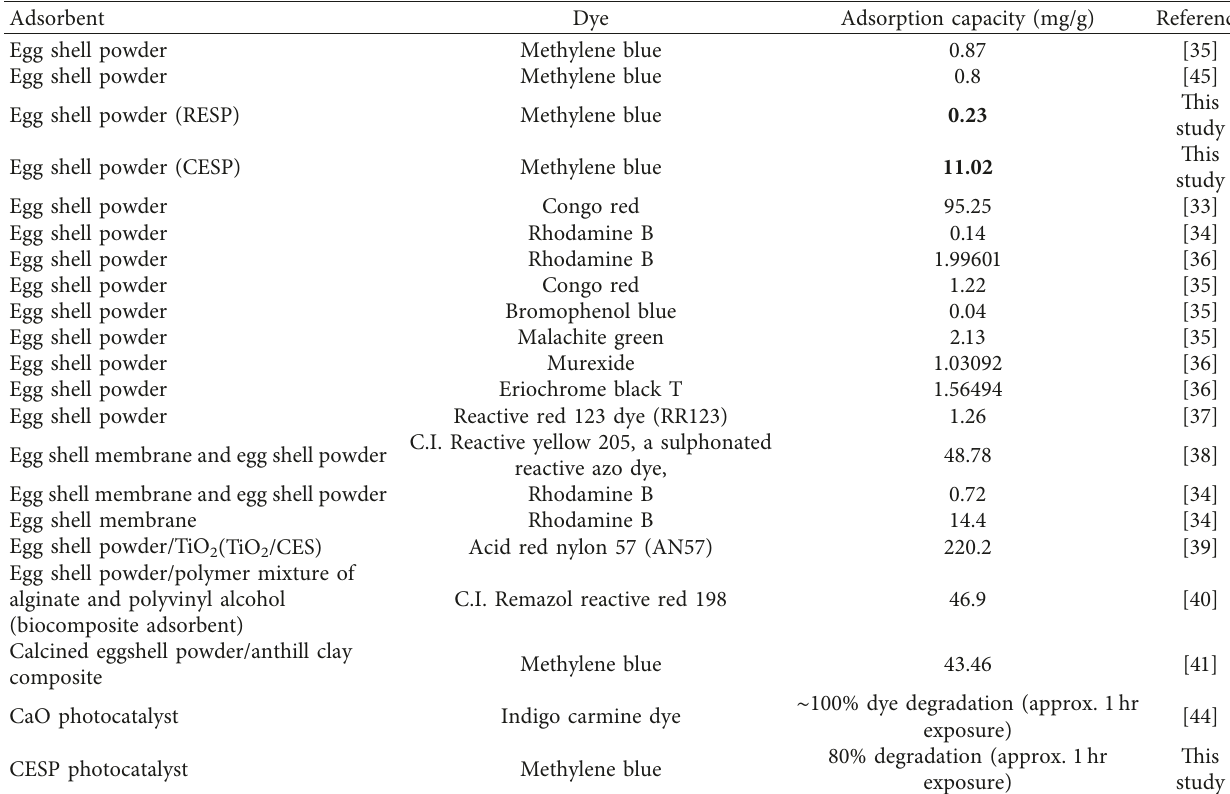
Table 3: Comparison of egg shell powder-, egg shell membrane-, and egg shell powder-based composite materials for dye adsorption. Adsorbent